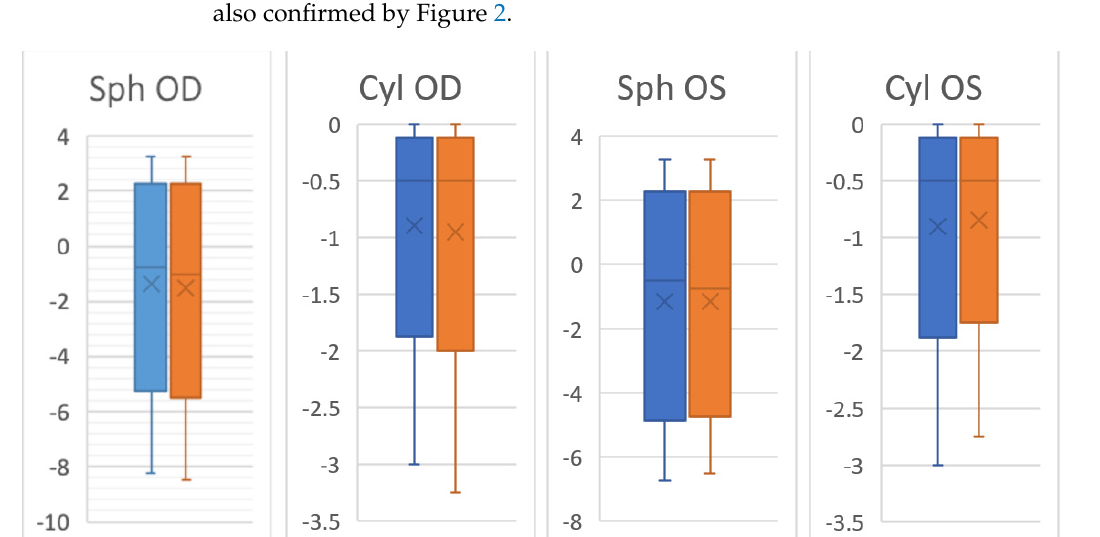
Figure 2. Dispersions statistics in the standing Position (blue) and the sitting position (orange). Sph OD = right eye sphere; Cyl OD = right eye cylinder; Sph OS = left eye sphere; Cyl OS = left eye cylinder.